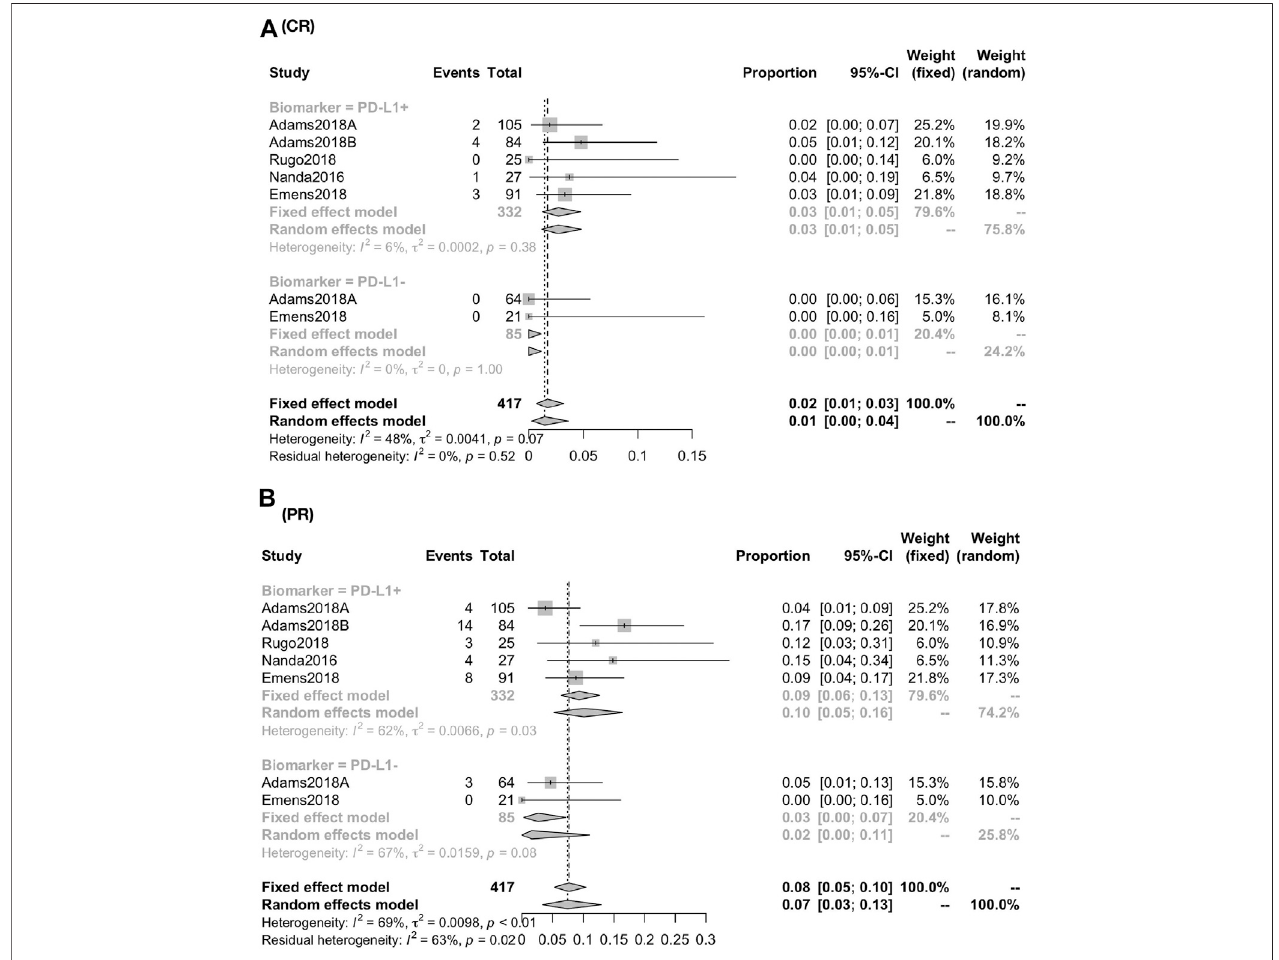
FIGURE 3 | Global response rate between PD-1+ and PD-L1 − for patients of CR (A) and PR (B) . The response rate was closely associated with the expression of PD-L1 biomarker (PD-L1+ vs. PD-L1 − ): the CR was 2.71% (95% CI, 1.24 – 4.72; I 2 , 05.00) vs. 0.00% (95% CI, 0.00 – 1.13; I 2 , 00.00); the PR was 9.93% (95% CI, 4.85 – 16.37; I 2 , 61.60) vs. 2.69% (95% CI, 0.01 – 8.03; I 2 ,